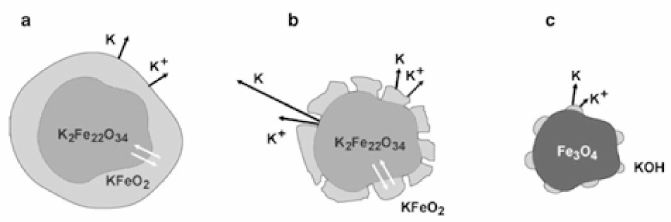
Figure 7. K cladding model [81]. ( a ) an ideal compact core and shell, ( b ) a more realistic core and cracked shell, and ( c ) deactivated catalyst grain morphology. Copyright 2002,